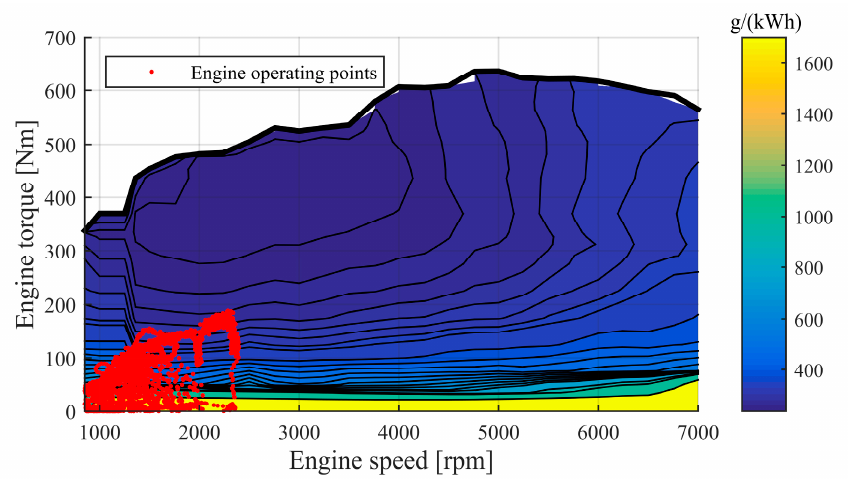
Figure 5. Experimental b ICE ( ω ICE , T ICE ) map for θ ICE = 90 ◦ C, with indication of the ICE operating points during the NEDC.